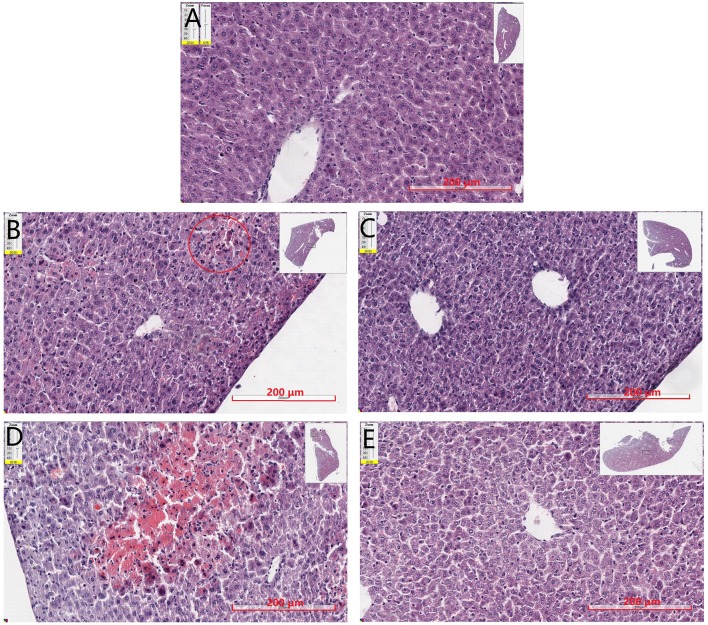
Mouse hepatic pathology. Liver sections were stained by HE, scanned by slide scanner, and the images are displayed at 200× magnification. (A) Mice from control group. (B) Mice treated with 150 mg·kg−1 APAP. (C) Mice treated with 150 mg·kg−1 APAP and SP600125. (D) Mice treated with 175 mg·kg−1 APAP. (E) Mice treated with 175 mg·kg−1 APAP and SP600125.